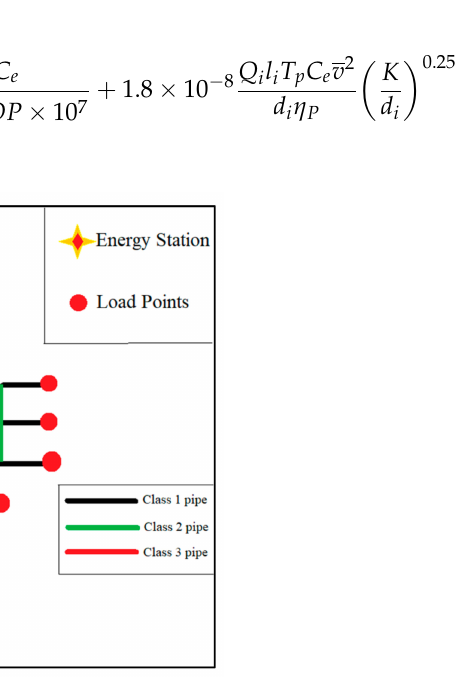
Figure 10. Pipe Diameter Grading when the classification of the pipe is